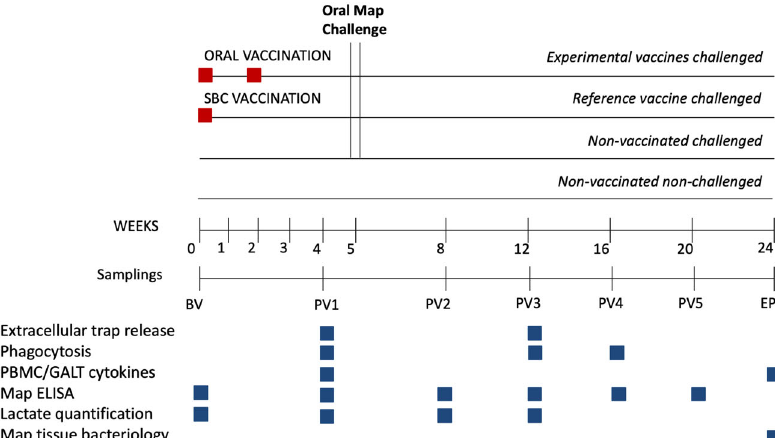
Fig. 1 Experimental scheme. Interventions and sampling points used to study trained immunity in ex vivo functional assays and protection in vivo after infectious challenge with